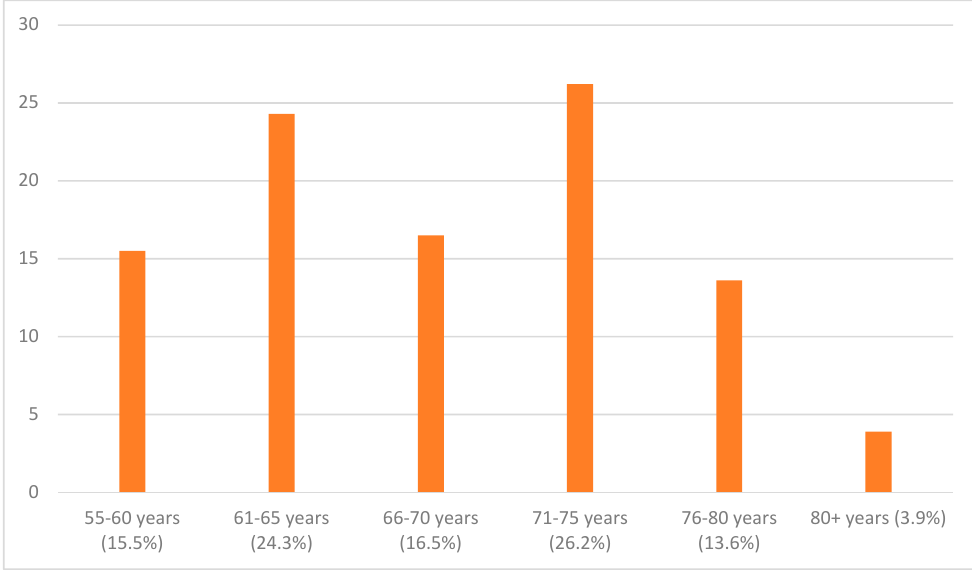
Figure 1. Age distribution of the experimental group.